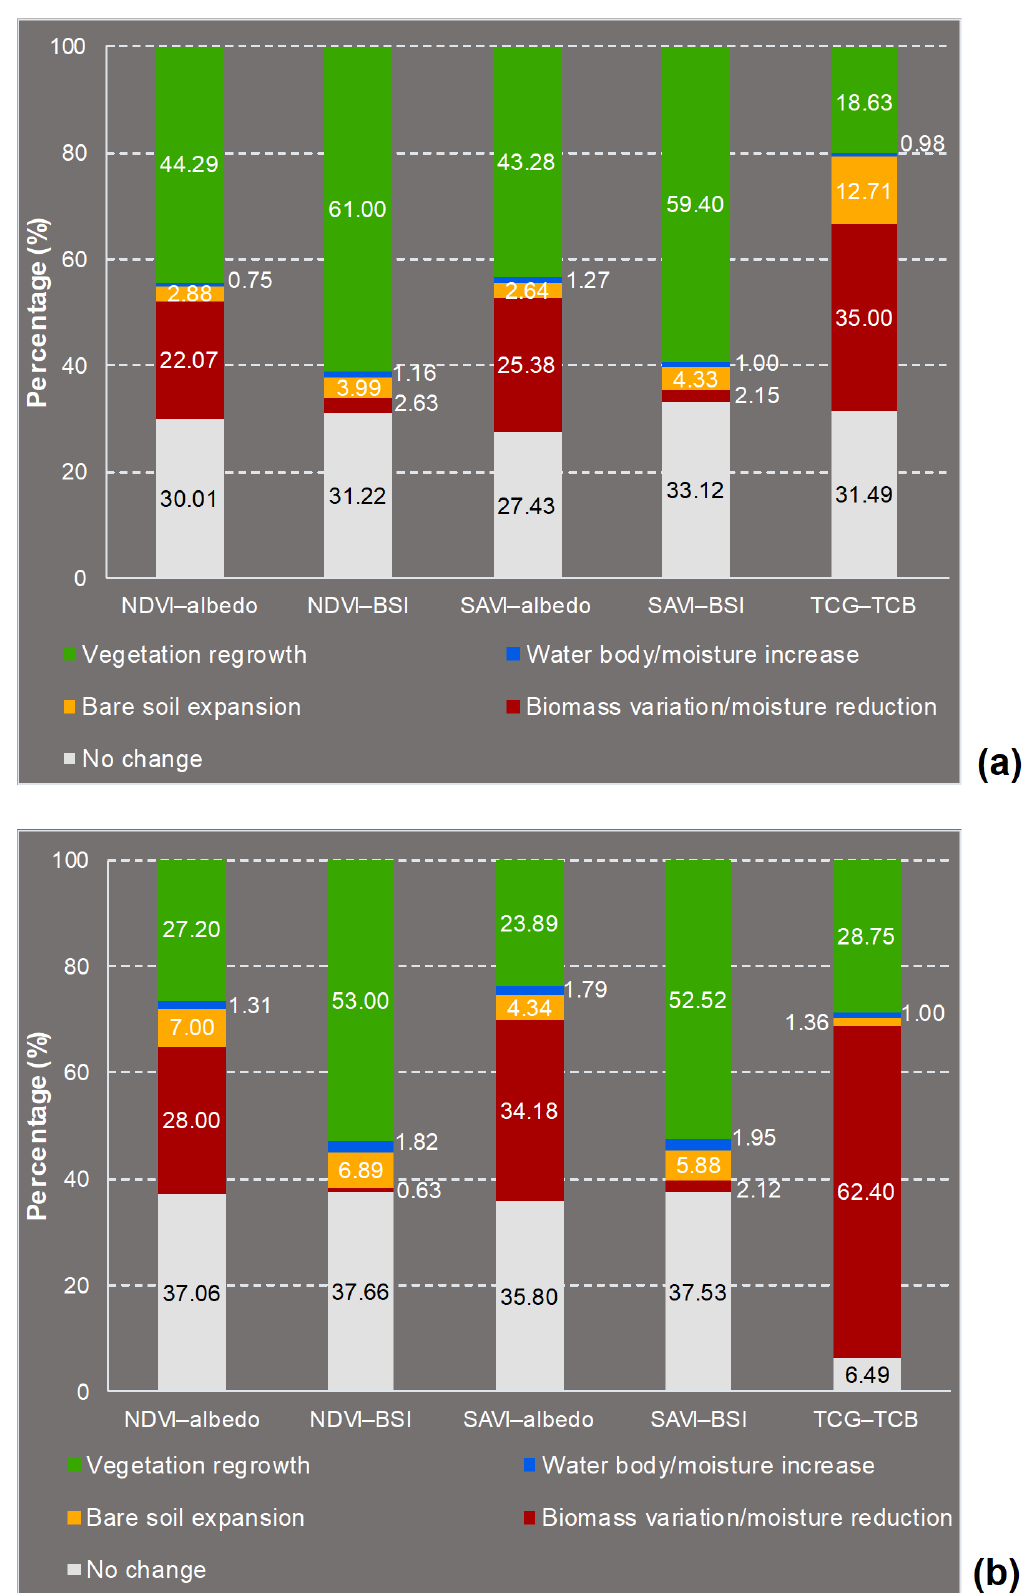
Figure 9. Area percentages of change direction categories produced by different index combinations: ( a ) 1999–2009; ( b ) 2009–2019.